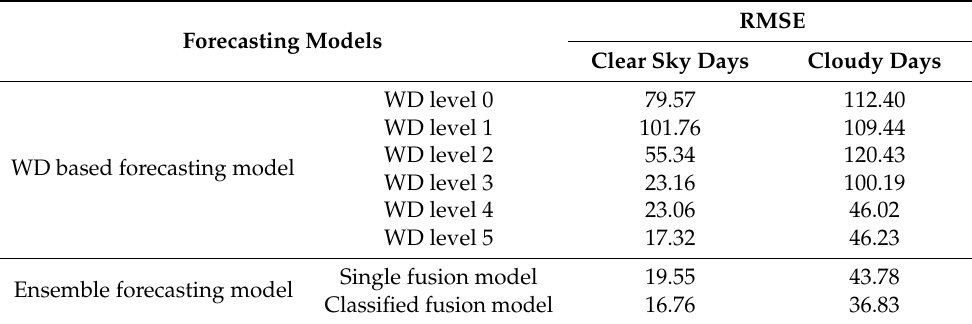
Table 1. The performance of models under different weather conditions.